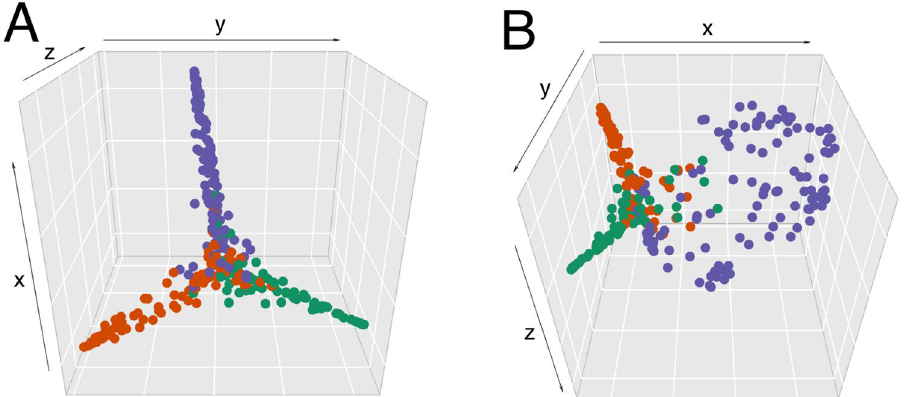
Figure 8. Resolution of patients with acute respiratory illness (ARI) into three clusters corresponding to bacterial infection, viral infection, and non-infectious illness (GSE63990). A cohort (GSE63990) having multiple types of pathogen infections has been analyzed using a Random Forest - multidimensional scaling (RF-MDS) process that combines the pan-viral signature and the SeptiCyte TM LAB signature 41 . Panel (A): A three-dimensional projection of points from an 8-dimensional space defined by the expression levels of the 8 individual genes comprising the two signatures. This projection was chosen to show maximal visual separation between the three clinical groups (bacterial, viral, and non-infectious illness). Panel (B): Another three-dimensional projection, chosen to show the relatively high dispersion of the virally infected samples. Key: bacterial, green points; viral, purple points; non-infectious illness, orange